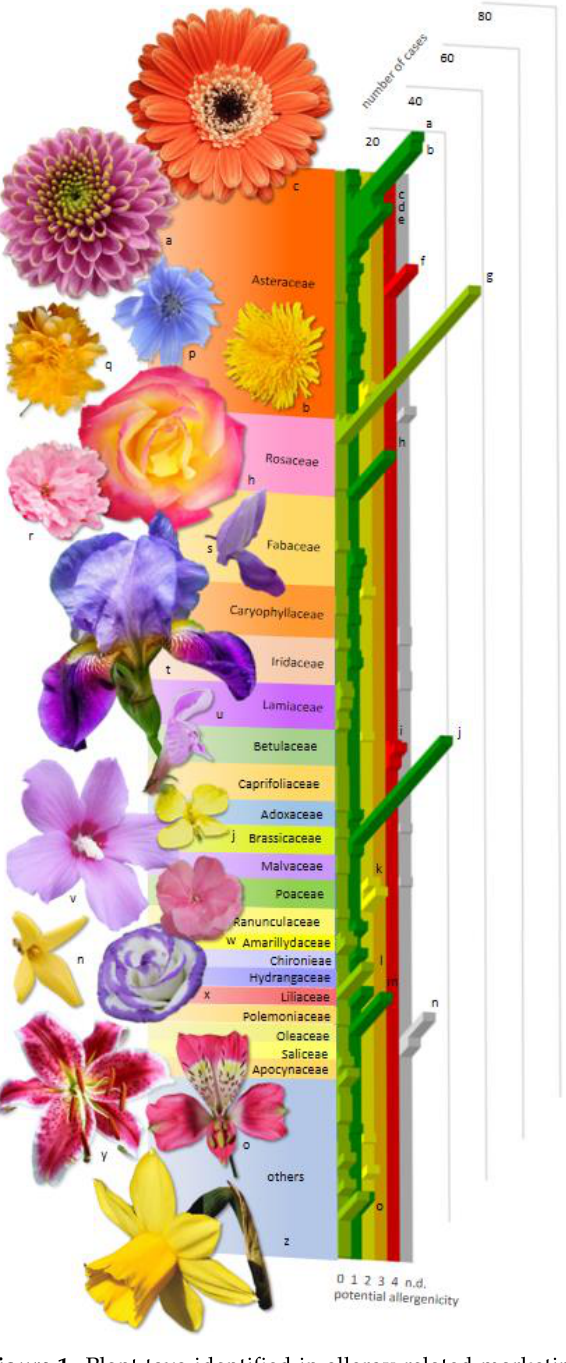
Figure 1. Plant taxa identified in allergy-related marketing materials. On the right side, a graph shows the number of cases (occurrence of plant species in allergy-related marketing materials) in allergenicity groups 0 – 4 plus n.d. (light green – gray graph bands). The potential allergenicity of plants is expressed by the CARE-S index [16], where 0: non allergenic (light green), 1: low (dark green), 2: medium (yellow), 3: high (orange), 4: very high (red) potential allergenicity, n.d.: no data (gray). The names of individual plant species are not shown (for this, see Table 2), but they are grouped according to plant families. Some remarkable species, however, are highlighted on the graph